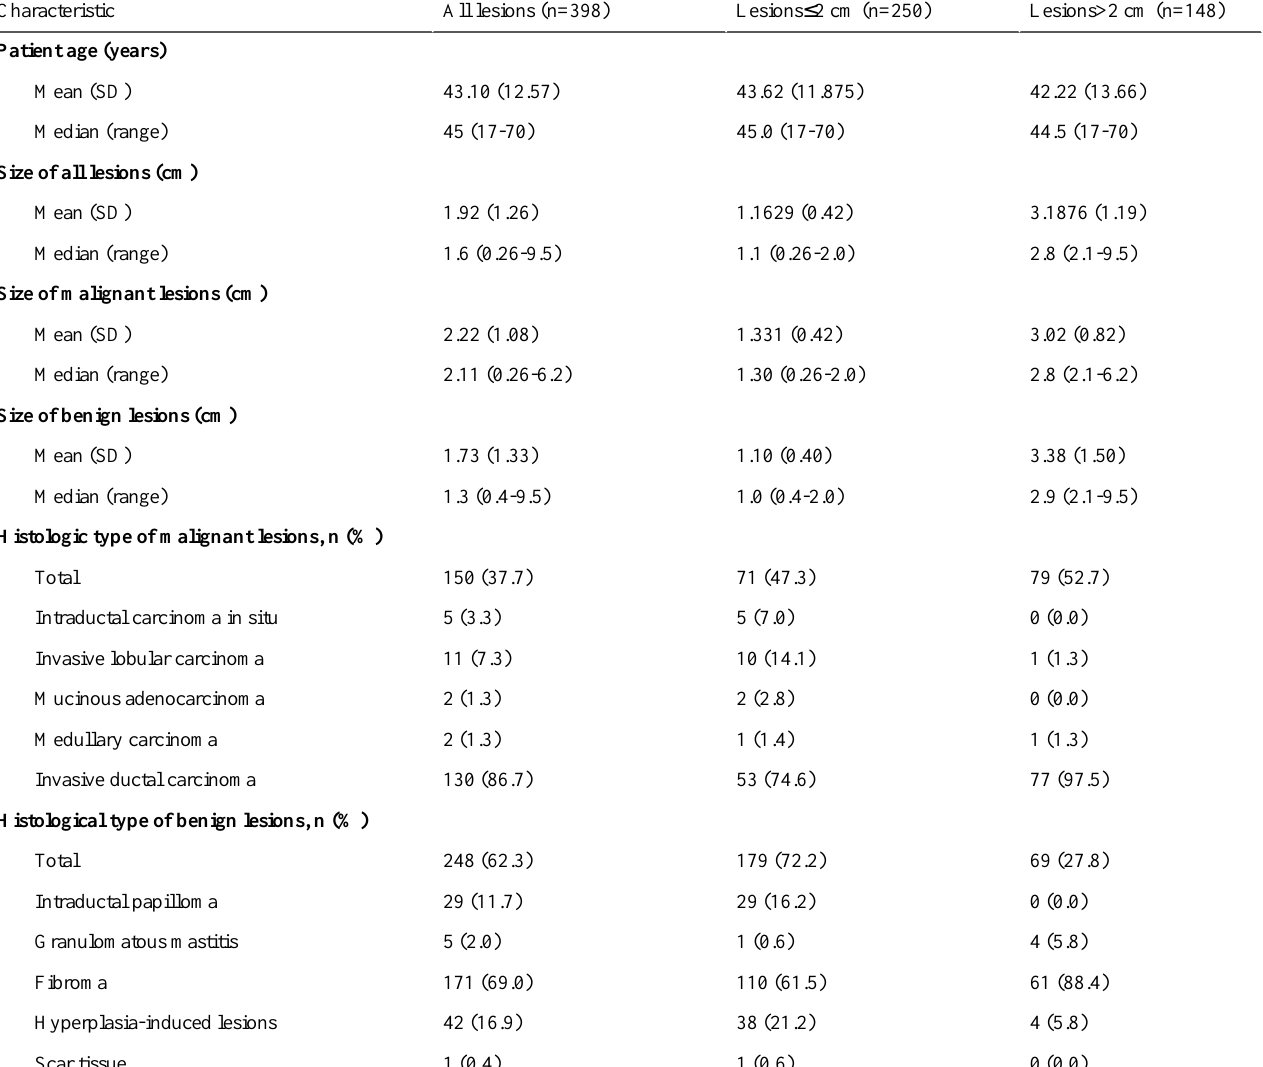
Table 1. Characteristics of patients and